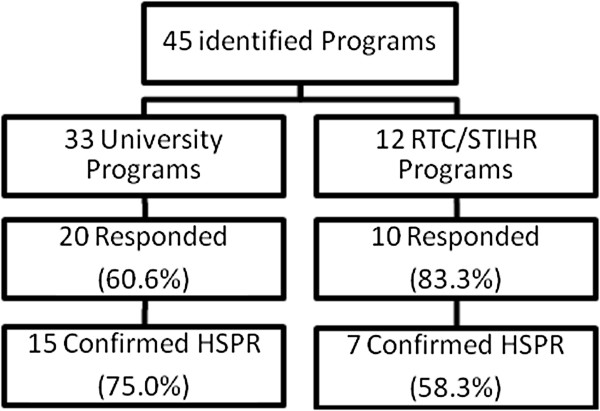
Survey responses from HSPR programs in Canada.